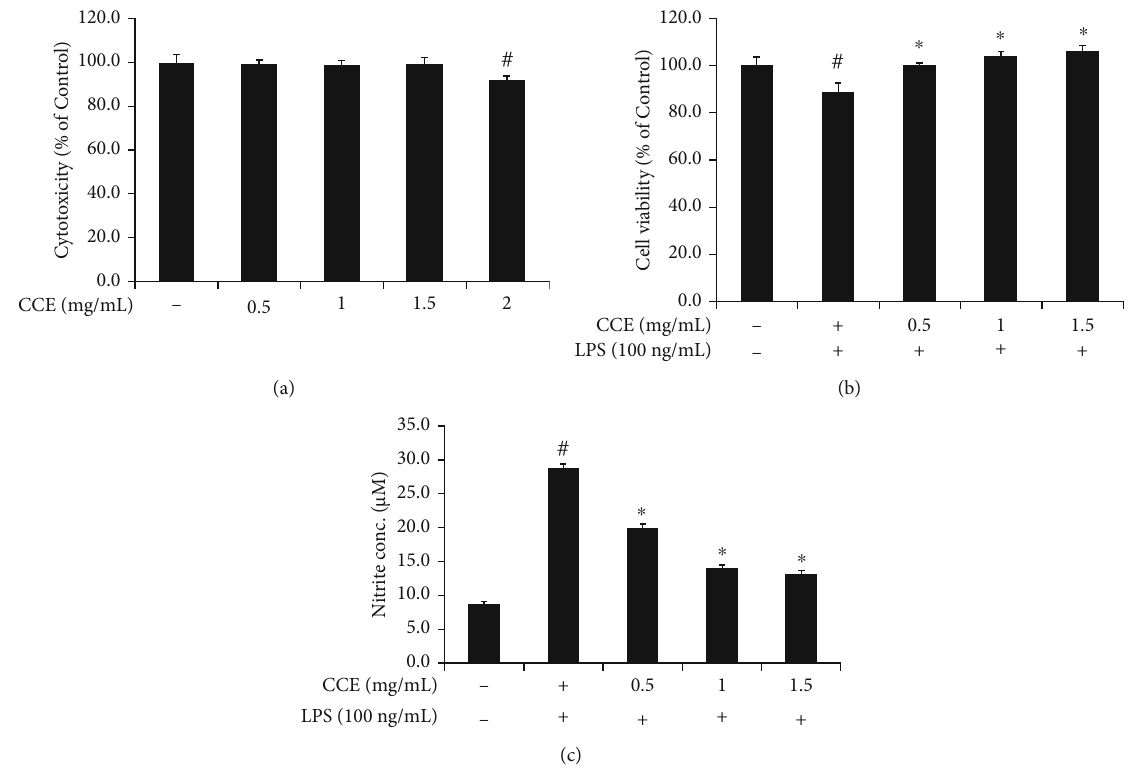
Figure 2: Commelina communis extract (CCE) treatment restricts nitric oxide (NO) production in lipopolysaccharide- (LPS-) exposed RAW 264.7 cells. (a) Cytotoxicity, (b) viability, and (c) NO levels of murine macrophages. Murine macrophages were treated with 100ng/mL LPS. The cytotoxicity and cellular viability were measured using MTT assay, and NO levels were evaluated using Griess reaction. Data were compared between groups using Student ’ s t -test and one-way analysis of variance. The results are expressed as the mean ± standard deviation from three independent experiments. # P < 0 : 05 compared with the control; ∗ P < 0 : 05 compared with the LPS- exposed